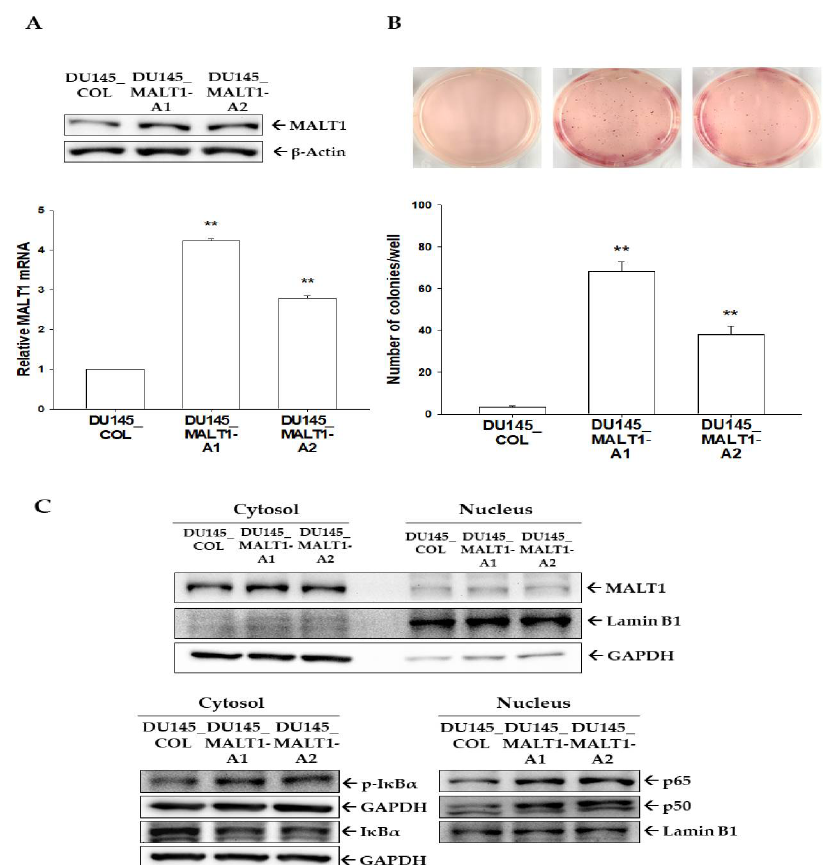
Figure 3. Modulation effect of MALT1 on tumorigenesis in vitro and NF- κ B activity in prostate carcinoma DU145 cells. ( A ) Protein levels (top) and mRNA levels (bottom) of MALT1 after ectopic overexpression in DU145 (DU145_MALT1-A1 and DU145_MALT1-A2) cells. Data are presented as mean fold-induction of the mRNA levels ( ± SE, n = 3) relative to the mock-transduced group. ( B ) In vitro tumorigenesis of MALT1-overexpressed DU145 cells was determined by soft agar assays. The numbers of colonies were counted (bottom) under a microscope ( ± SE, n = 6). ( C ) Expressions of MALT1, I κ B α , phospho- I κ B α , p65, p50, Lamin B1, and GAPDH in cells after separation of nuclear and cytoplasmic fractions as indicated were determined by immunoblot assays. ** p <